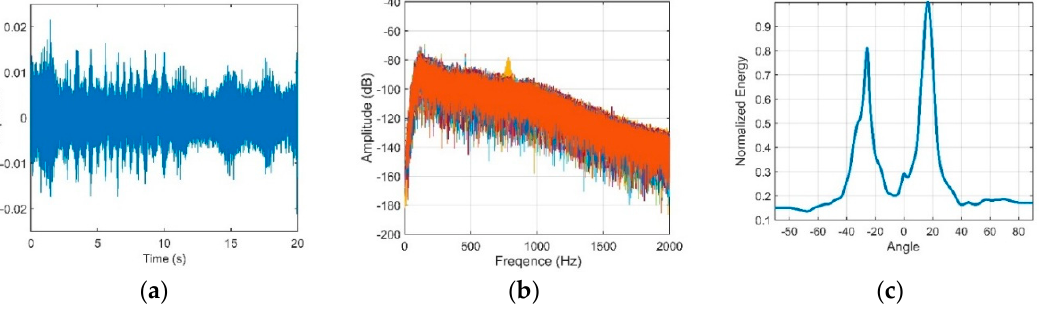
Figure 22. ( a ) Noise waveform; ( b ) Noise frequency through a 100 Hz to 1 kHz bandpass filter; ( c ) Directionality of the noise.